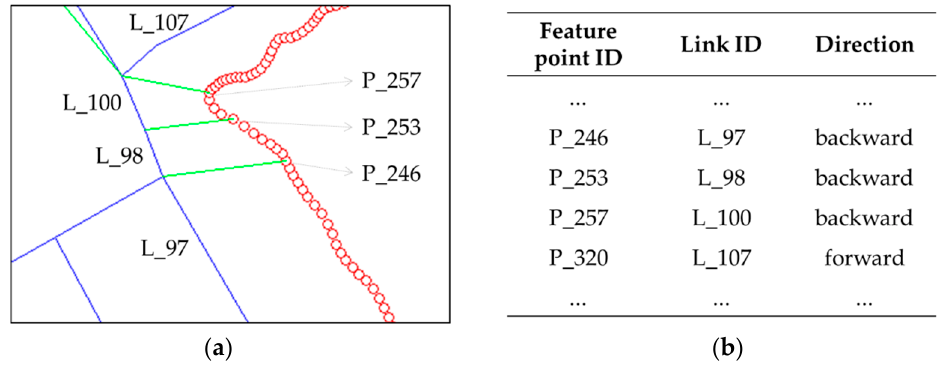
Figure 11. A part of the ground truth dataset ( a ) and its matching table ( b ), identified manually for selected feature points from Route 6. Thick lines are the PND links and circles are the GPS-recorded points. Lines connecting points and PND are the reference matches of the ground truth dataset. In this example, points between P_246 and P_253 should be matched to PND link L_98 and the direction of the link is opposite to that of the GPS signal.